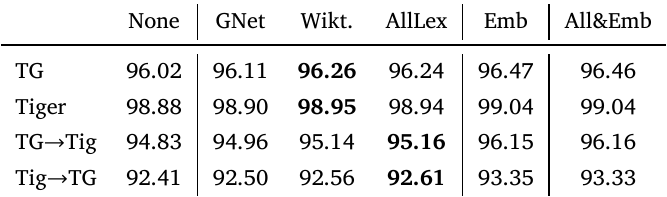
Table 19: None GNet Wikt. AllLex Emb All&Emb POS (sSTTS) accuracy in % for combinations TG 96.02 96.11 96.26 96.24 96.47 96.46 of German lexica and word Tiger 98.88 embeddings, using MarMoT with Komninos, based on the merged German corpus